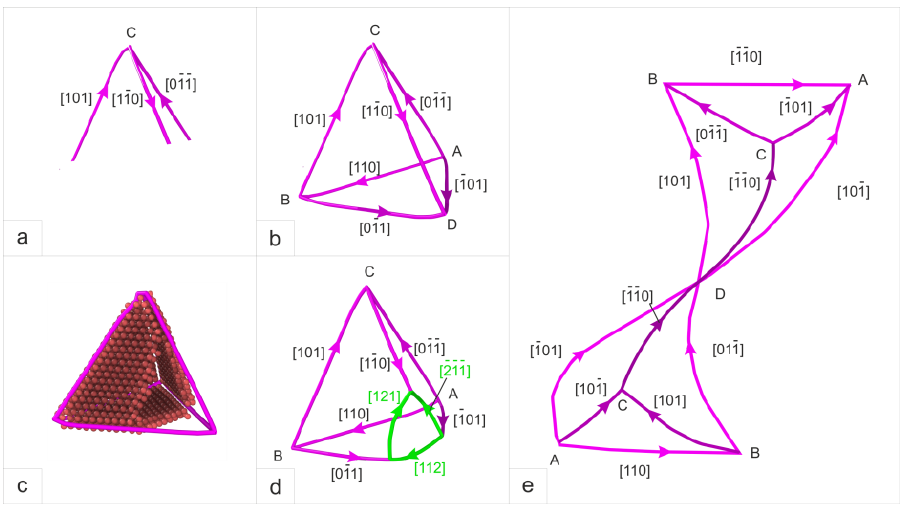
〈110〉 junction; ( b ) 𝑎 〈110〉 dislo- (cid:104) 110 (cid:105) junction; ( b ) a (cid:104) 110 (cid:105) disloca- 6 6 6 6 〈110〉 dislocations tetrahedron with (cid:104) 110 (cid:105) dislocations tetrahedron with Shockley 6 6